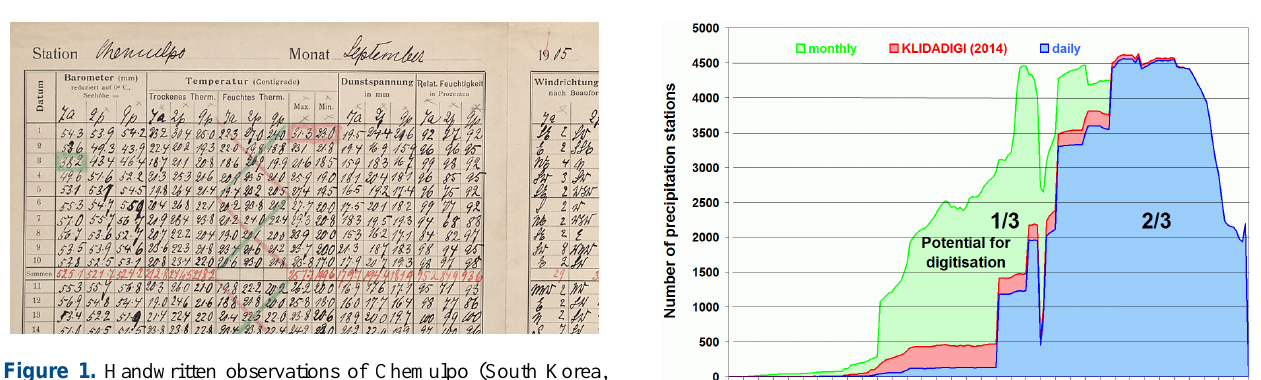
Figure 1. Handwritten observations of Chemulpo (South Korea, 37 ◦ 28 (cid:48) N, 126 ◦ 38 (cid:48) E) from September 1905.